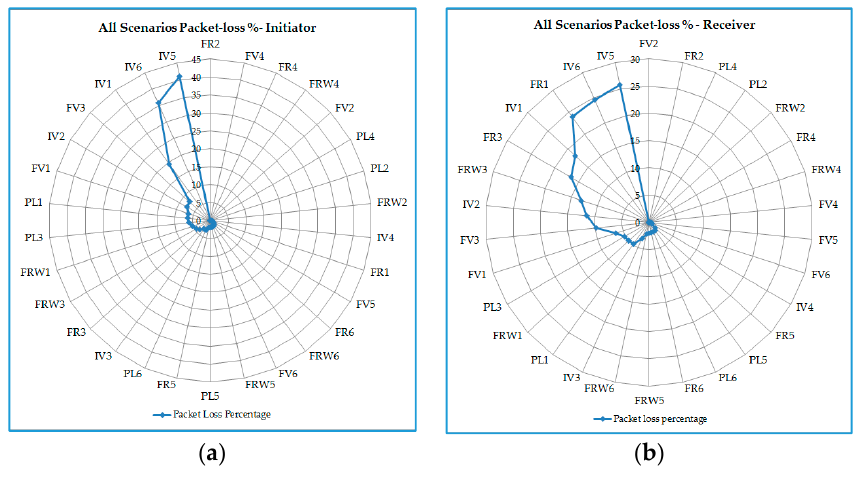
Figure 17. All scenarios’ average jitter comparison for: ( a ) VoIP initiators; ( b ) VoIP receivers. Information 2017 , 8 , 88